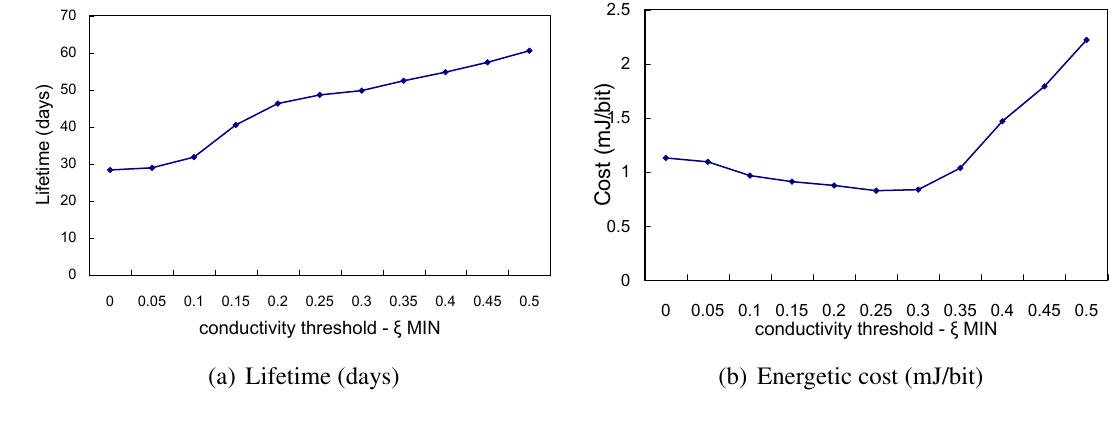
Figure 3. TEAR protocol performance vs. minimum conductivity threshold ( ξ from 0 to